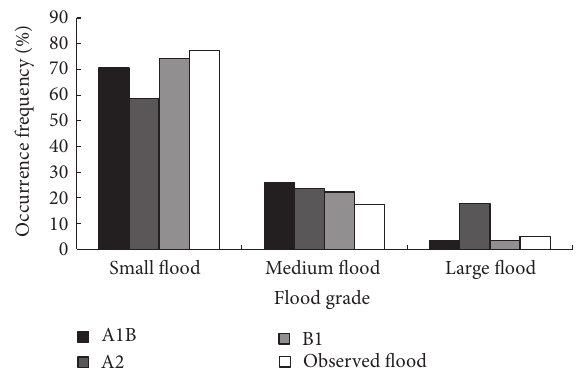
Figure 12: The frequency of occurrence of floods within standard size grades under three climate change scenarios and under histori- cal